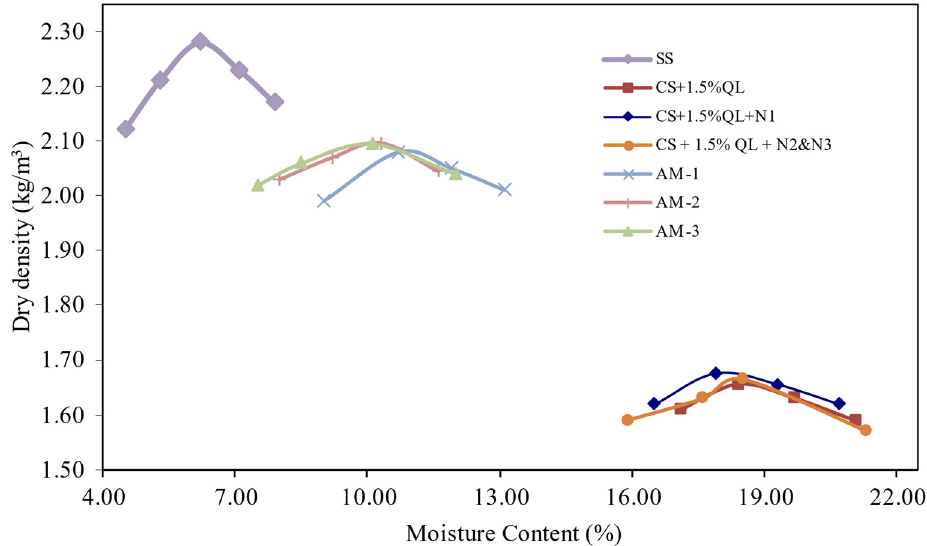
Figure 7. Moisture–dry density curves.